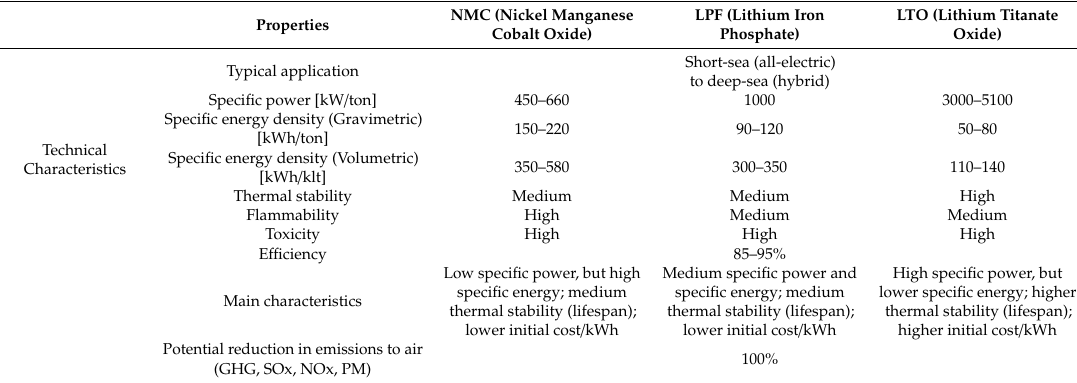
Table 1. Main Technical Characteristics of Lithium-Ion Marine Batteries [3].